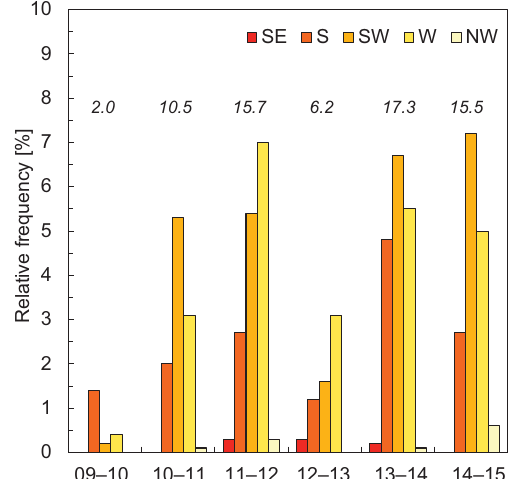
Figure 11. Relative frequency (as percentage of all hourly observa- tions) of strong gale or more ( ≥ 20.8ms − 1 ) at Juvvasshøe during winter (Oct–Apr) 2009–2015 for the wind sectors SE to NW. The values inserted show the total frequency of strong gale or more.